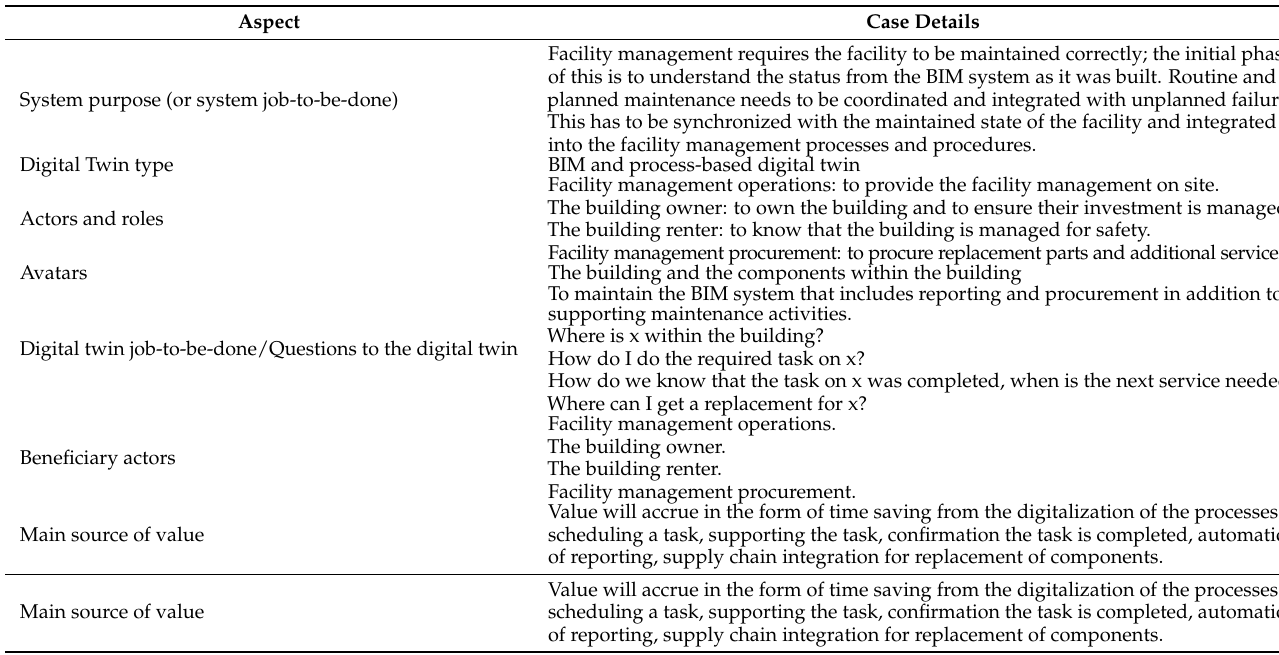
Table A12. Case 10—operations support in facility